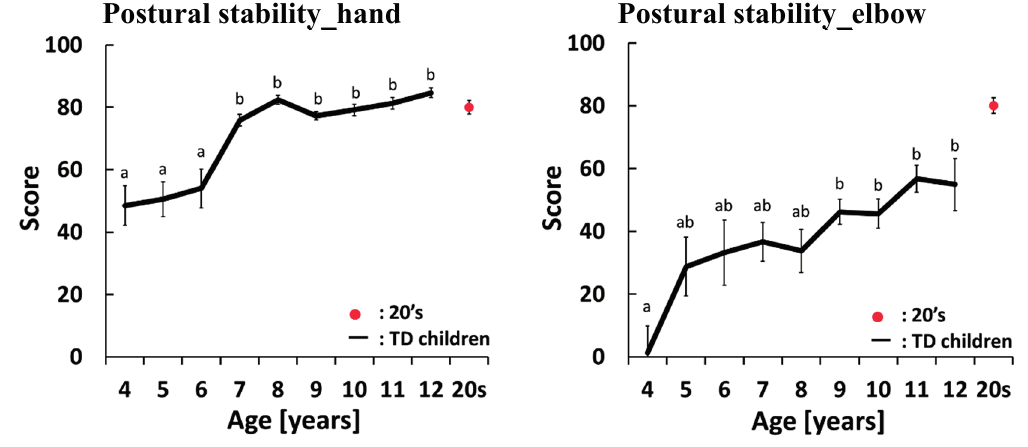
Figure 3. Average and standard error of scores in the imitative motor task. The black line shows the average score for TD children. The red dot shows the average score for participants aged 21–26 years old. There is a significant difference between two different letters which do not include same alphabet on each standard error bars ( p <